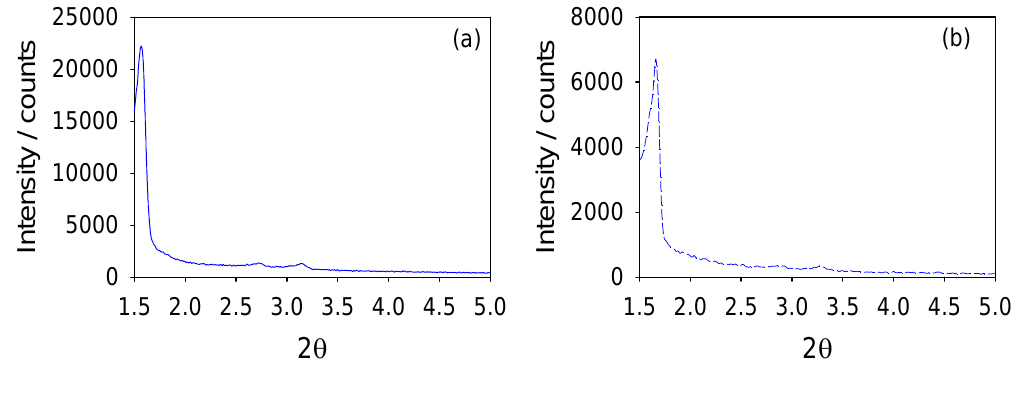
Figure 7. XRD patterns of the reduced sample Pd/Benzene-PMO ( a ) before; and ( b ) after being used as catalyst in the Suzuki cross-coupling